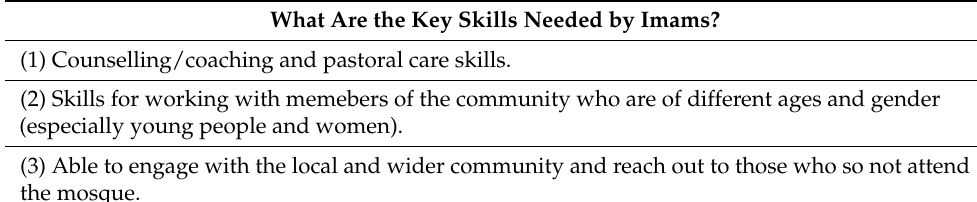
Table 6. Interpretative content analysis Delphi 3. Workshop question